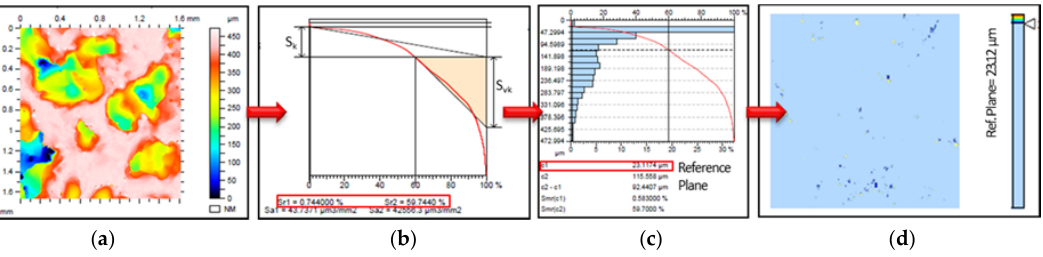
Figure 2. Steps to achieve the reference plane of each conditioned wheel surface. ( a ) Surface topography, ( b ) Abbot-Firestone curve and its corresponding functional parameters, ( c ) Abbot-Firestone curve and material distribution and ( d ) reference plane showing sliced material.